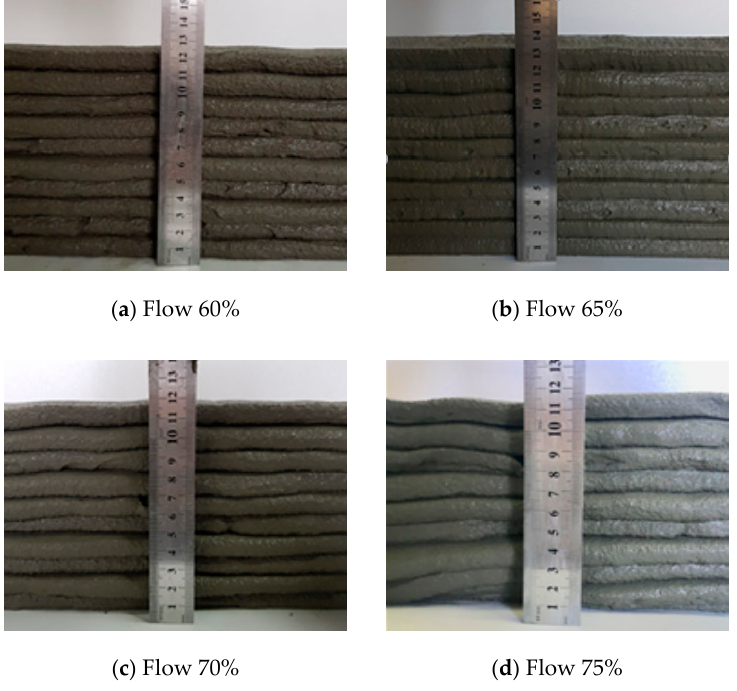
Figure 2. Test results determining the optimal flow [15].